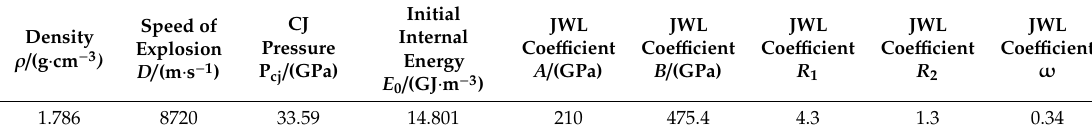
Table 3. Calculation parameters of desensitized RDX.